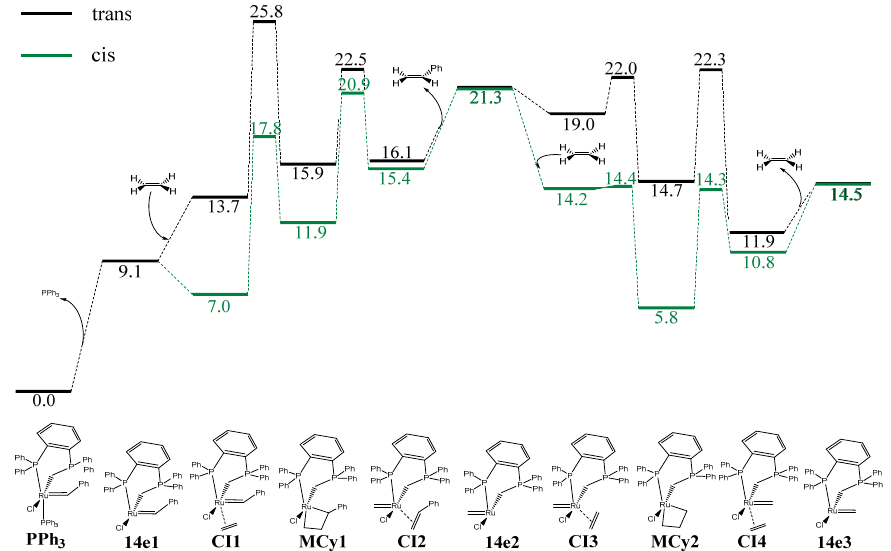
Figure 3. In-solvent (CH 2 Cl 2 ) M06/TZVP~SDD//BP86/SVP~SDD free-energy profile for the olefin metathesis reaction catalyzed by complex A ( A = PPh 3 here) using ethylene as substrate (energies in kcal/mol). The cis and trans modes (in black and green, respectively) correspond to the regioselectivity of the coordination of ethylene with respect to the PPh 2 moiety of the phosphine-phosphonium ylide